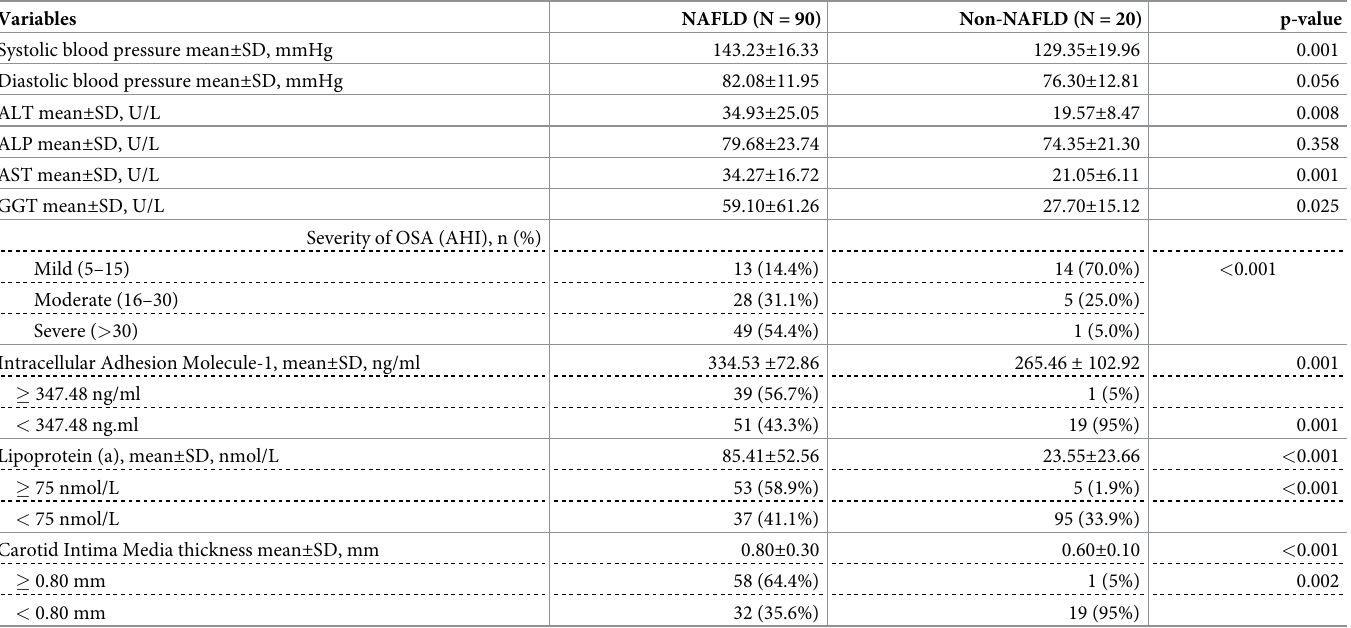
Table 2. Comparison between non-NAFLD and NAFLD group.